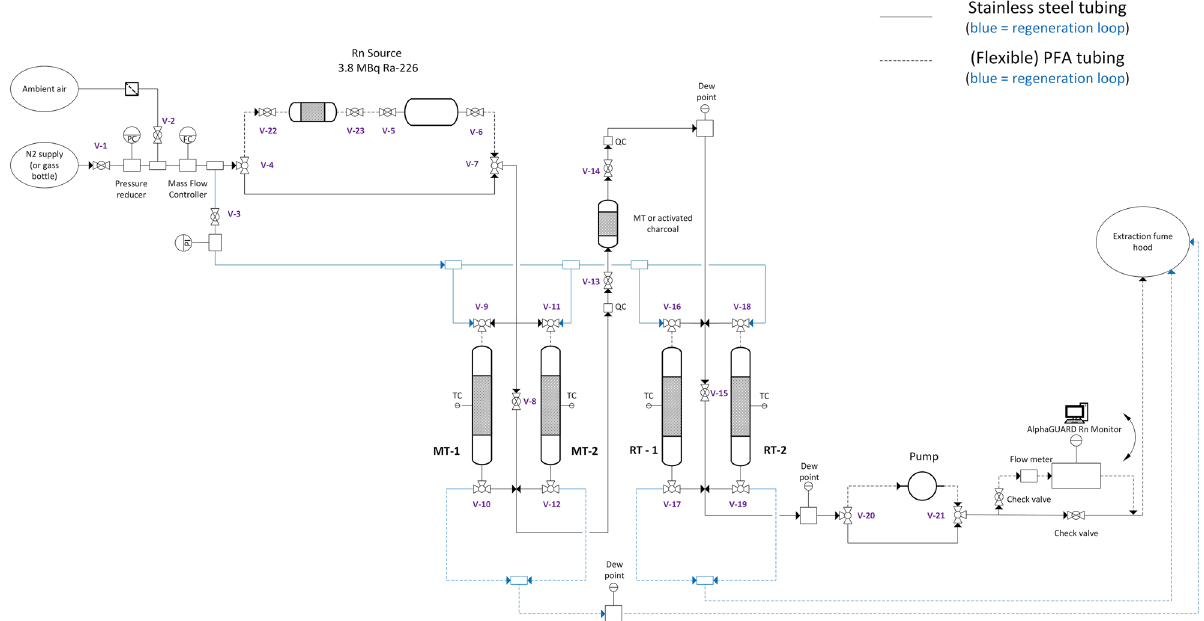
Figure 5. Schematic representation of the setup used for 222 Rn adsorption